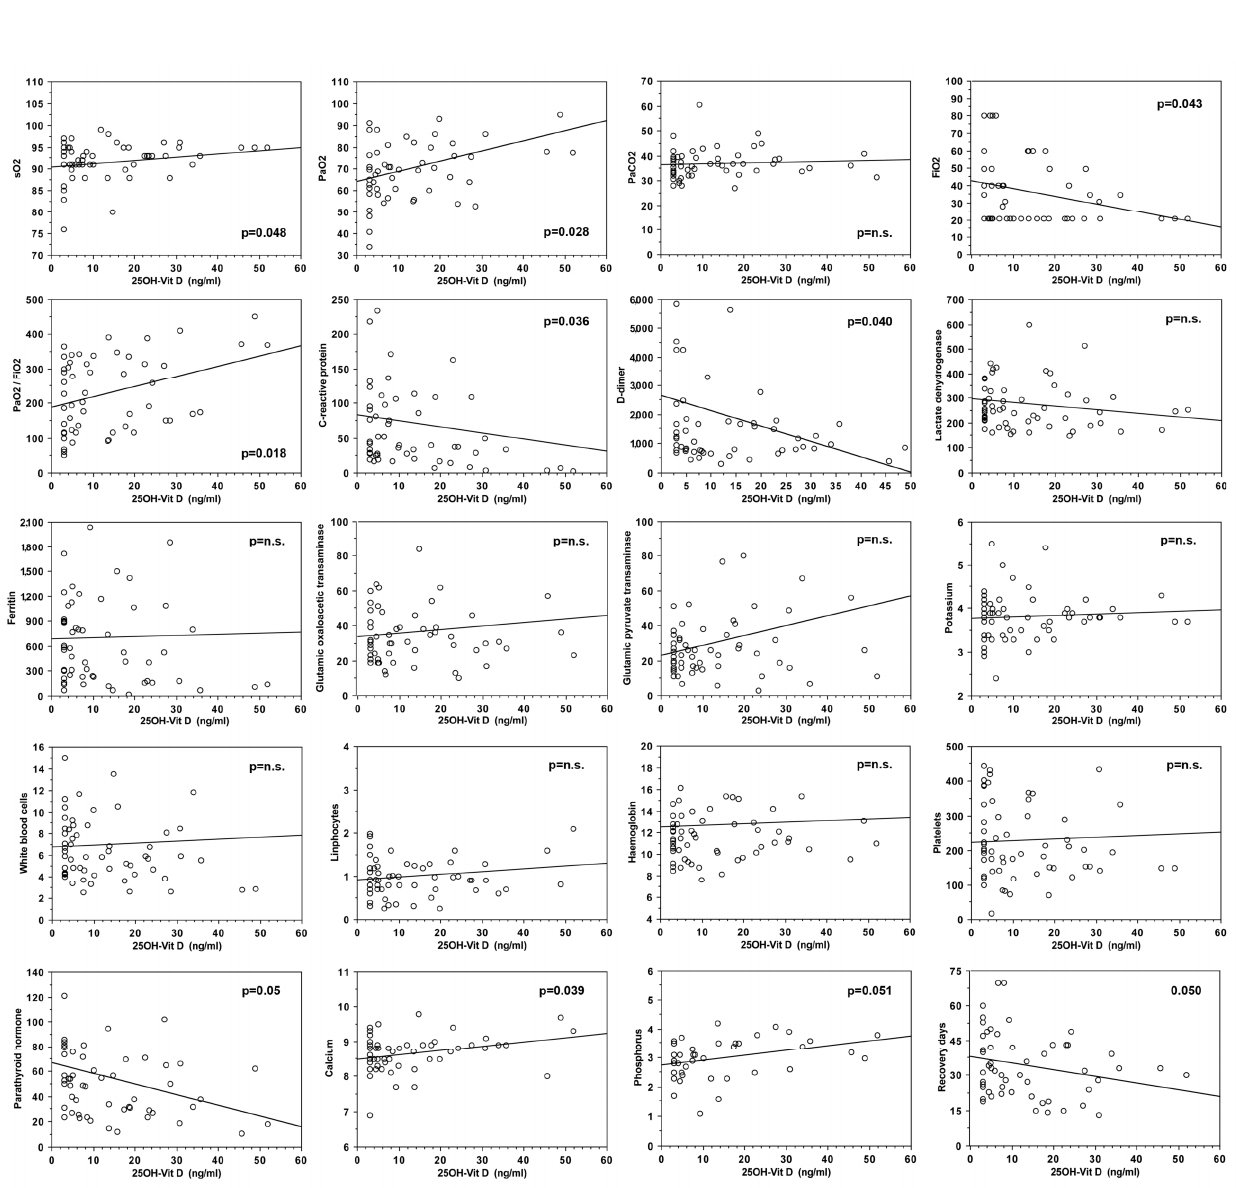
Figure 2. Correlations between 25OH-vitamin D serum levels and clinical parameters in COVID-19 patients.